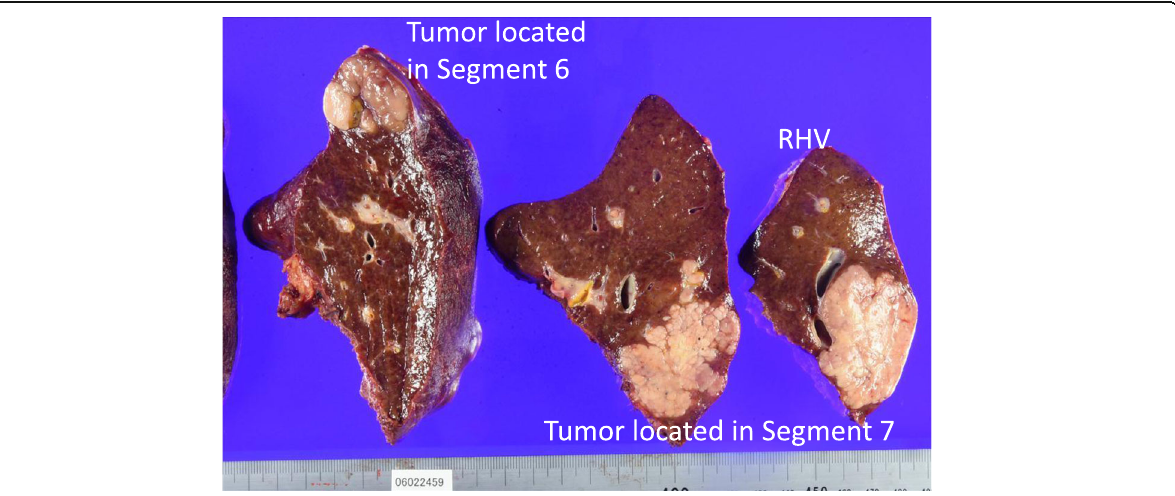
Fig. 5 Macroscopic findings of HCC. Both tumors were confluent, multinodular-type HCC. The right hepatic vein was surrounded by the tumor, but a venous thrombus was not detected. HCC, hepatocellular